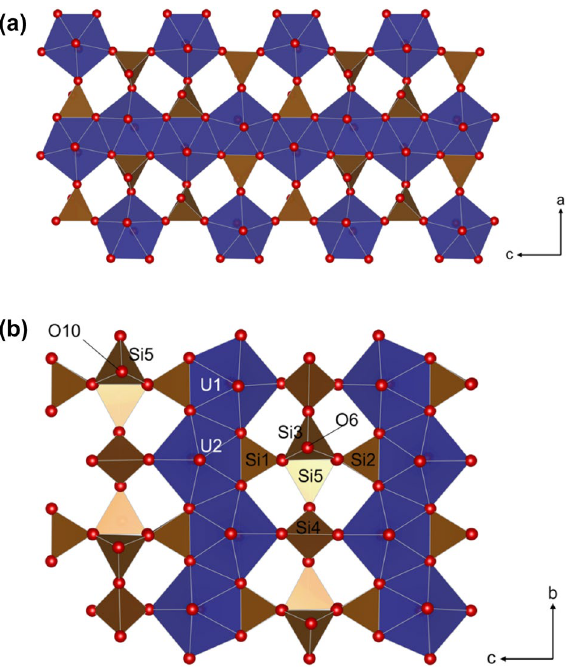
Figure 8. Crystal structures of uranophane-β (Ca(UO 2 ) 2 SiO 3 (OH) 2 ·5H 2 O) and haiweeite (Ca[(UO 2 ) 2 Si 5 O 12 (OH) 2 ]·3H 2 O). Silicon tetrahedron are in brown/beige and uranyl pentagonal bipyramids are in blue. ( a ) View of uranophane-β uranyl silicate layer along (0 1 0). ( b ) Uranyl silicate sheet in the crystal structure of haiweeite along (1 0 0). It should be noted that in weeksite (K 2 (UO 2 ) 2 Si 6 O 15 ·4H 2 O), the (1 0 0) view is the same as for haiweeite; however, the Si3 Q 3 tetrahedron changes to a Q 4 species whereby O6 connects to a subsequent Q 4 species in the adjacent uranyl silicate